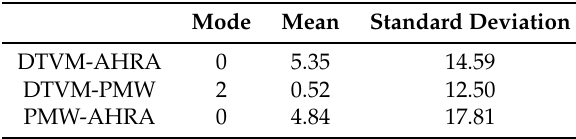
Table 1. Comparison between MO dates (in days) for the passive microwave MO methods used in this study.